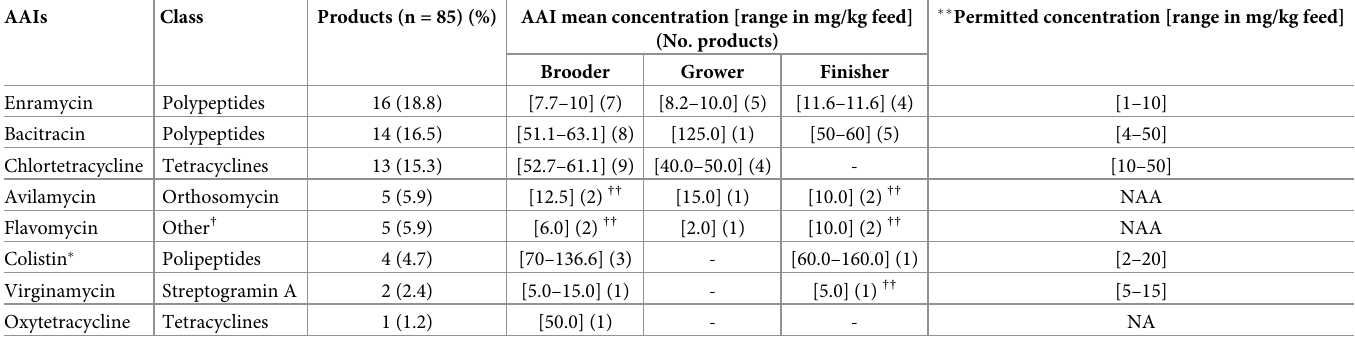
Table 1. Antimicrobial Active Ingredients (AAIs) and their concentrations in 85 chicken feed products given to flocks in Dong Thap (Mekong Delta, Vietnam). AAIs